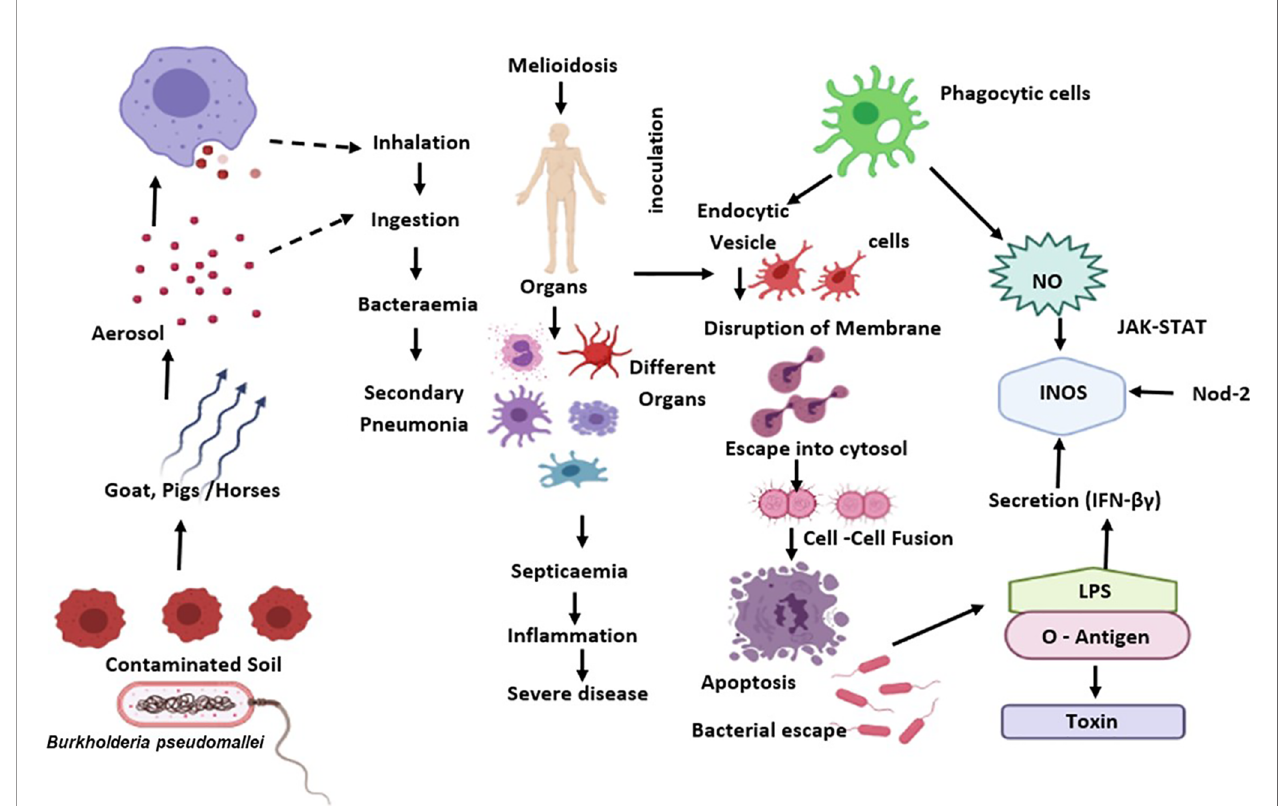
FIGURE 1 | B. pseudomallei is diffused from the external reservoir to respiratory epithelial cells where the initial attachment initiates possibly through capsule and type IV pili. Upon invasion of epithelial cells, the T3SS-3 effectors promote in vacuolar evade and intracellular motility via BimA-mediated actin polymerization. Subsequent to phagocytosis, B. pseudomallei exits the phagosome and enters the host cytoplasm to replicates. This eventually causes the host cell death through initiation of apoptosis. The B. pseudomallei LPS regulates IFN secretion, which down-regulates iNOS expression and NO production. Also, B. pseudomallei in fl uence the regulation of suppressor of cytokine signalling and cytokine-inducible Src homology 2-containing proteins that obstruct the JAK – STAT signalling pathway and iNOS